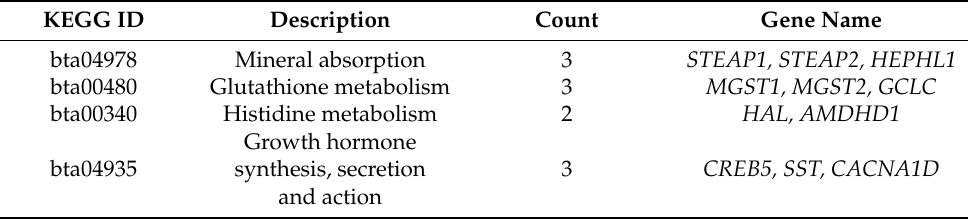
Table 4. Details of the KEGG (Kyoto Encyclopedia of Genes and Genomes) pathways analysis enriched from the nearest candidate genes and genes within 200 kb of the significant SNPs.